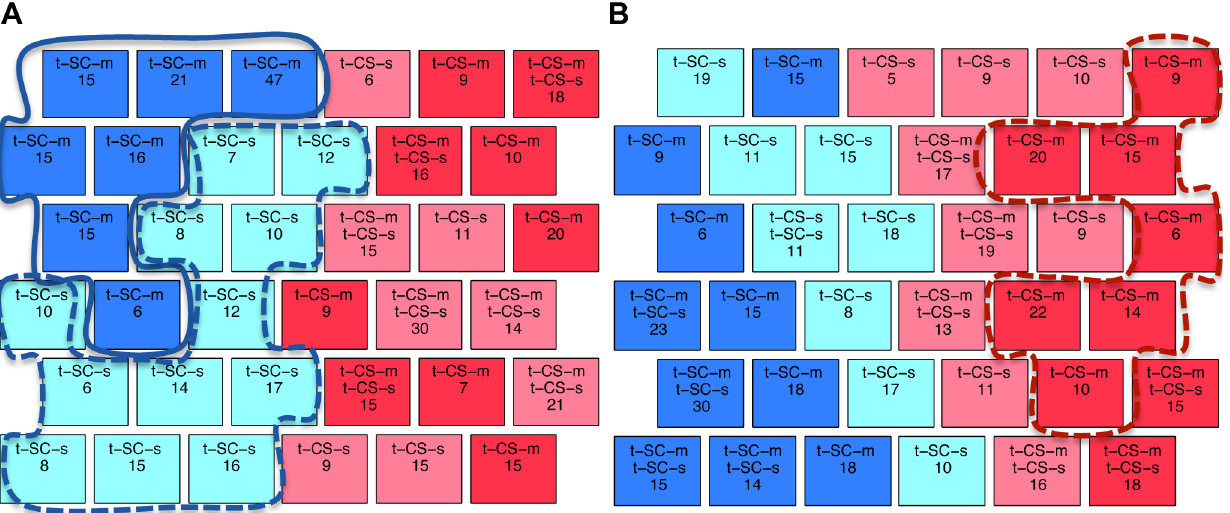
Fig 7. SOM clustering using subsets of proteins for trisomic mice. (A) Clustering of trisomic mice with proteins common to the two comparisons that reflected rescued learning: t-CS-m vs. t-SC-m and t-CS-m vs. t-SC-s (15 proteins), plus the initial effects of memantine: t-SC-m vs. t-SC-s (12 proteins). The t-SC-m cluster is outlined in solid blue and the t-SC-s cluster is outlined in dashed blue. (B) Clustering with the former 15 proteins (rescued learning) plus the 9 discriminant between t-CS-m and t-CS-s (S2 Table,